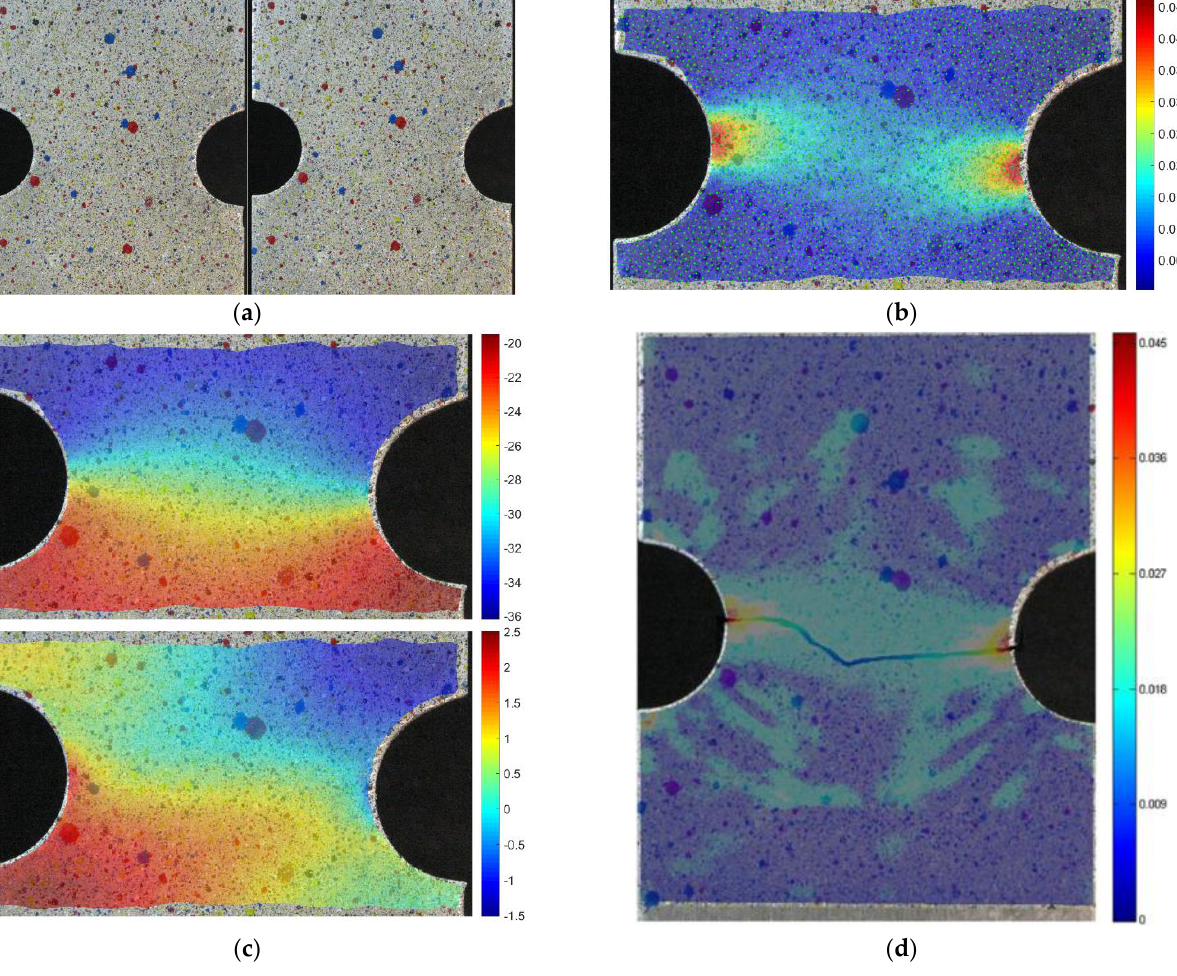
Figure 13. Unloaded and loaded aluminum specimen ( a ). Vertical and horizontal displacements due to loading ( c ) and equivalent strain maps for the aluminum alloy sample using RBF and tracking ( b ) and using modal tracking ( d ). ( b ) and using modal tracking ( d ).